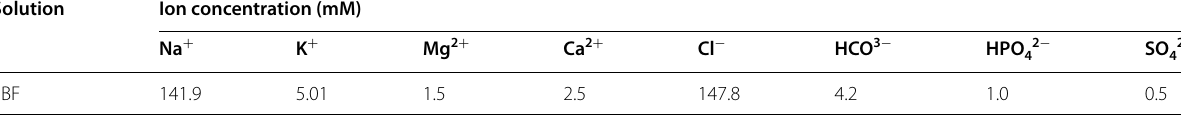
Table 1 Ion concentration (mM) in the simulated body fluid (SBF) (Iftekhar et al. 2008) Solution Ion concentration (mM) Na +